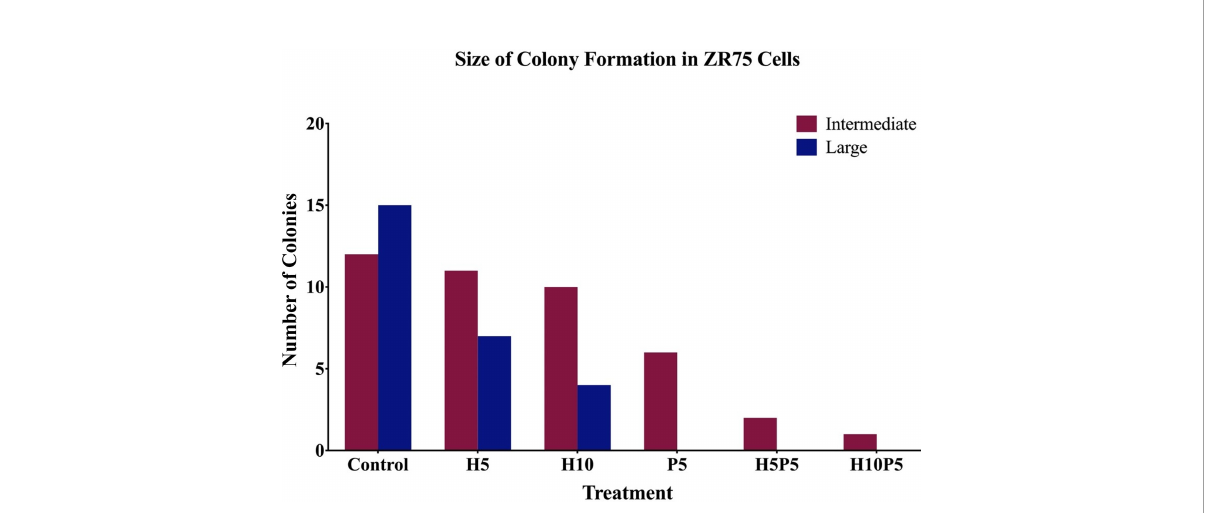
FIGURE 6 The number of big and intermediate colonies after 14 days of seeding in agar gel. It is shown that there is a considerable reduction in the number of colonies when treated with combination of TZ and BMS-202. Note that there are no big colonies in case of H5P5 and H10P5.